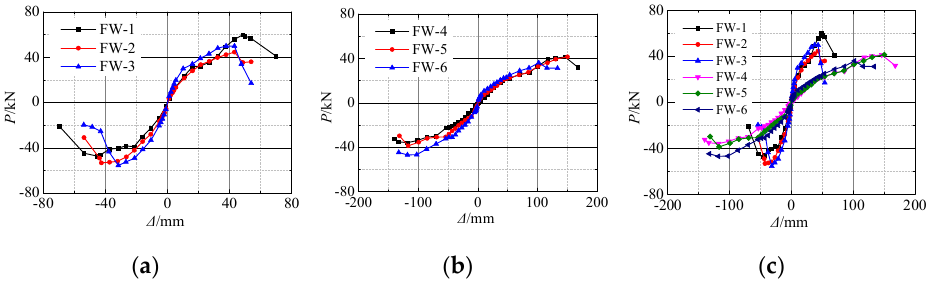
Figure 13. Comparisons of skeleton curves: ( a ) Specimens with rigid bracings; ( b ) Specimens with flexible bracings; ( c ) Comparison of all specimens.